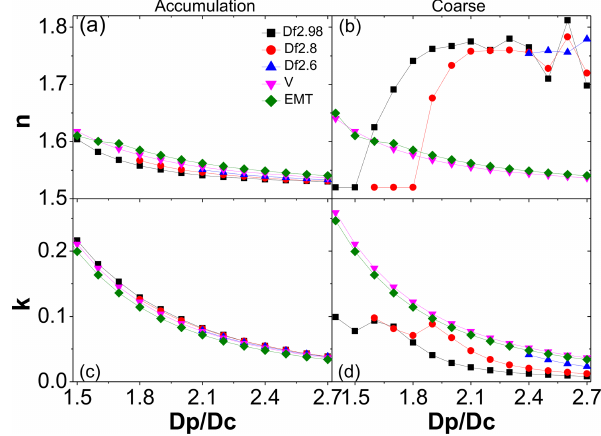
Figure 2. The real ( a and b ) and imaginary ( c and d ) parts of retrieved optically effective aerosol complex refractive indices (ACRIs) of black carbon aggregates coated by sulfate as a function of shell / core ratio ( D p /D c , spherical volume-equivalent particle di- ameter/BC core diameter), in accumulation ( a and c ) and coarse ( b and d ) modes, respectively. Black squares, red circles and blue up-triangles indicate BC fractal dimensions of 2.98, 2.8 and 2.6, respectively. The ACRIs given by the popular volume-weighted av- erage method (magenta down-triangles) and Bruggeman effective medium theory (olive diamonds) are also considered for compari- son.